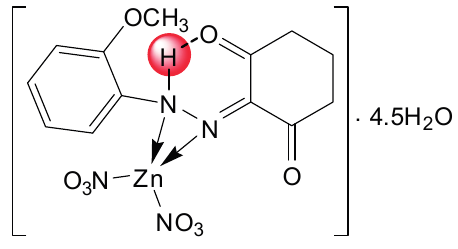
Figure 4. Structure of [Zn(L 1 )(NO 3 ) 2 ]·4.5H 2 O complex.